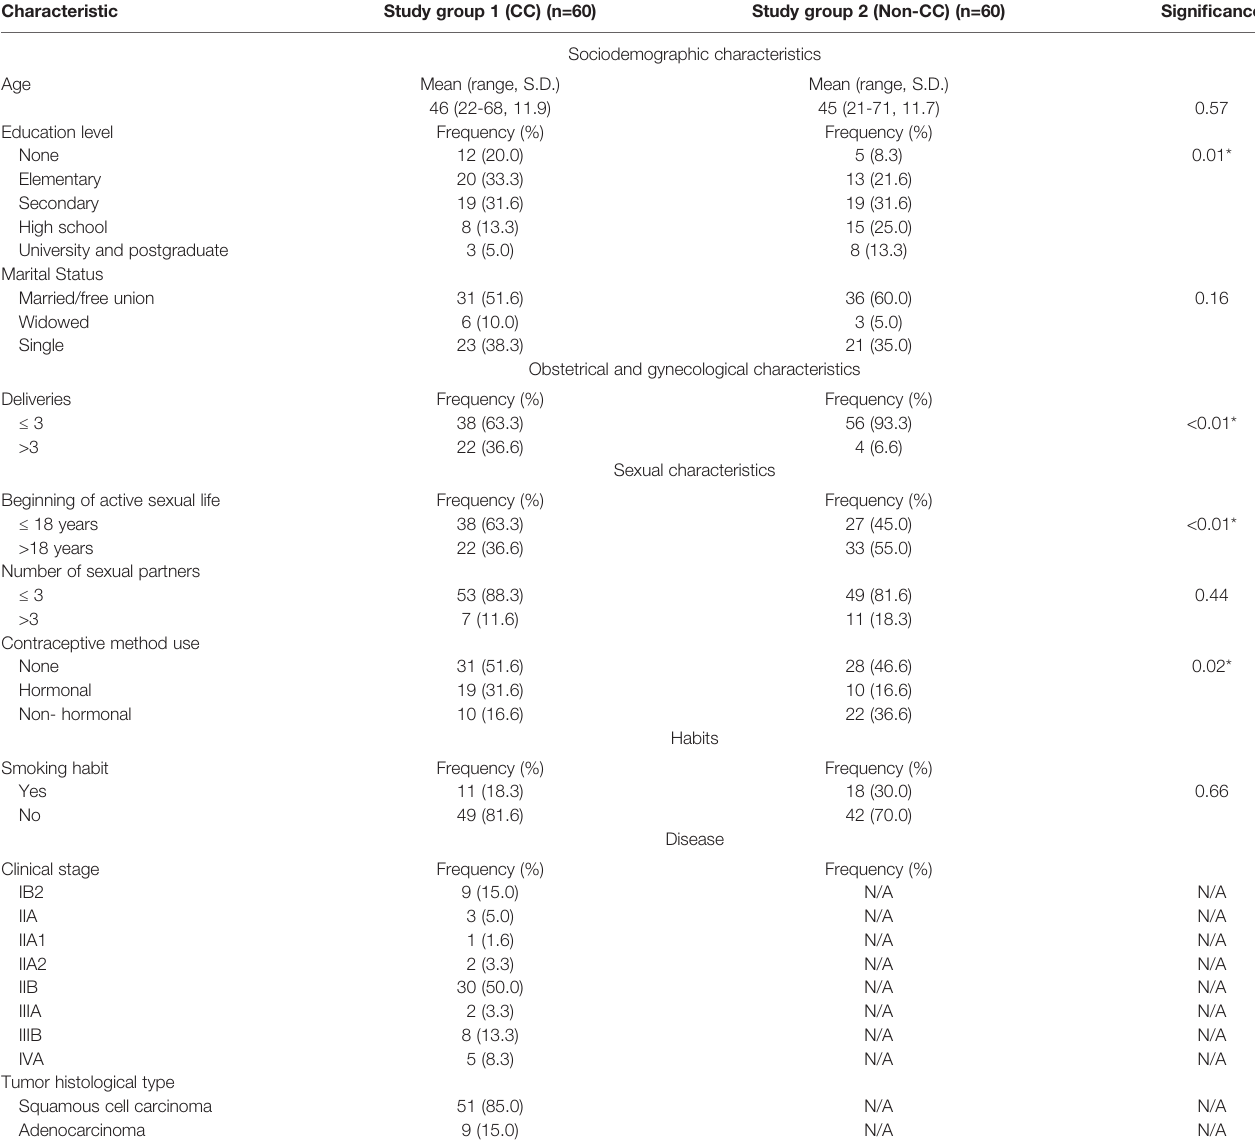
TABLE 1 | Characteristics of the study population.